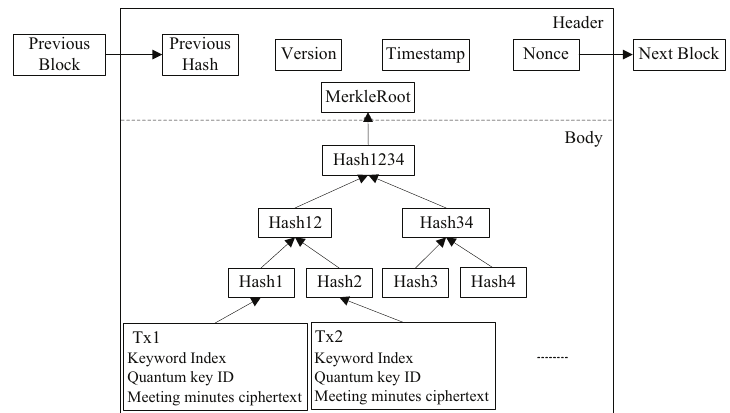
Figure 6. Alliance chain